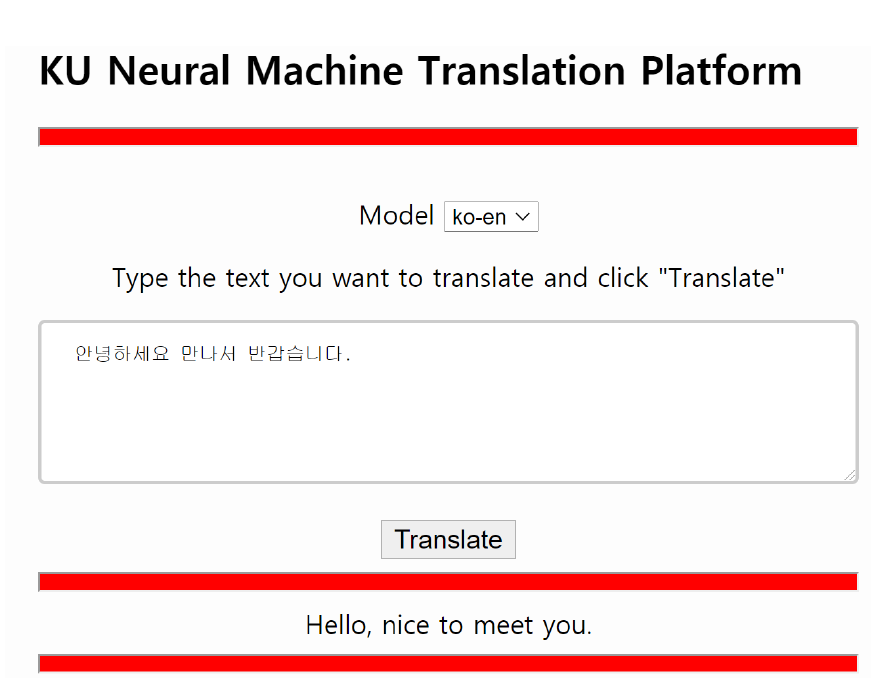
Figure 2. Korean–English neural machine translation platform execution process.